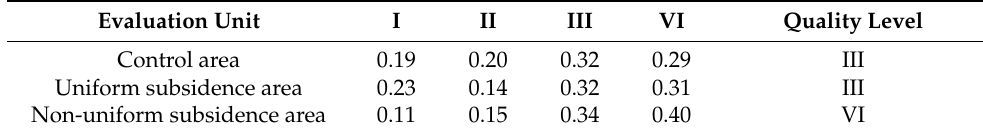
Table 6. The membership value of the target